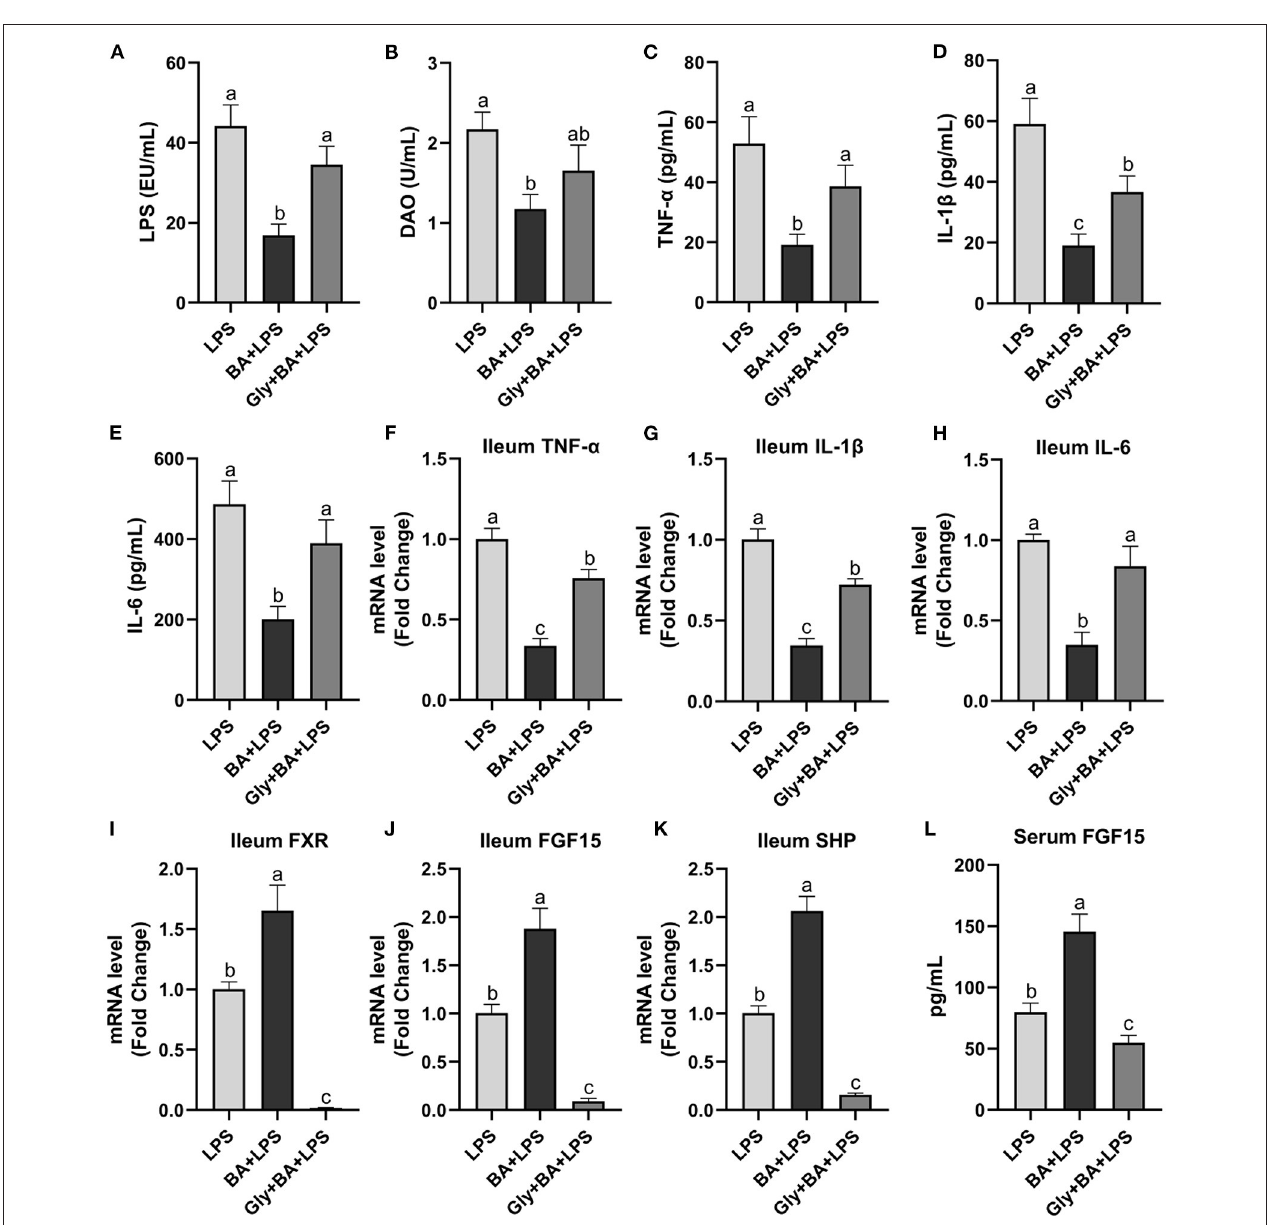
FIGURE 7 | The effect of CDCA and LCA on C57BL/6 mice injected with LPS in Experiment 3. (A) Serum lipopolysaccharide (LPS), (B) diamine oxidase (DAO), (C–E) serum tumor necrosis factor- α (TNF- α ), interleukin-1 β (IL-1 β ) and IL-6, and (F–H) the ileal inflammatory cytokine gene expression of TNF- α , IL-1 β and IL-6. (I,J) Gene expression levels of FXR and fibroblast growth factor 15 (FGF15) in the ileum. (K) Gene expression level of SHPs in the ileum. (L) Serum FGF15. LPS, a LPS injection group that oral gavaged with physiological saline before i.p. LPS injection; BA + LPS, a CDCA and LCA administration group that oral gavaged with a mixture